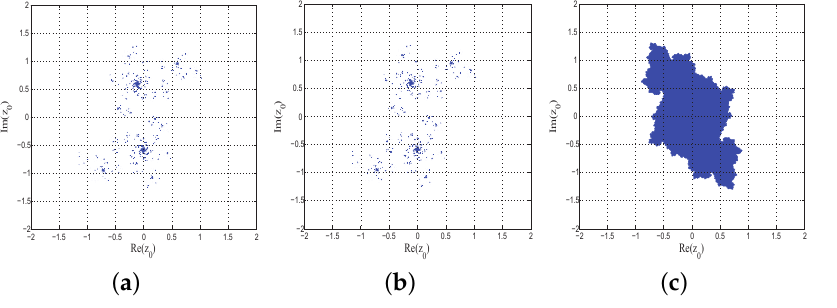
) 1 = 0.35 + 0.59 i , c 2 = 0.35 − 0.59 i